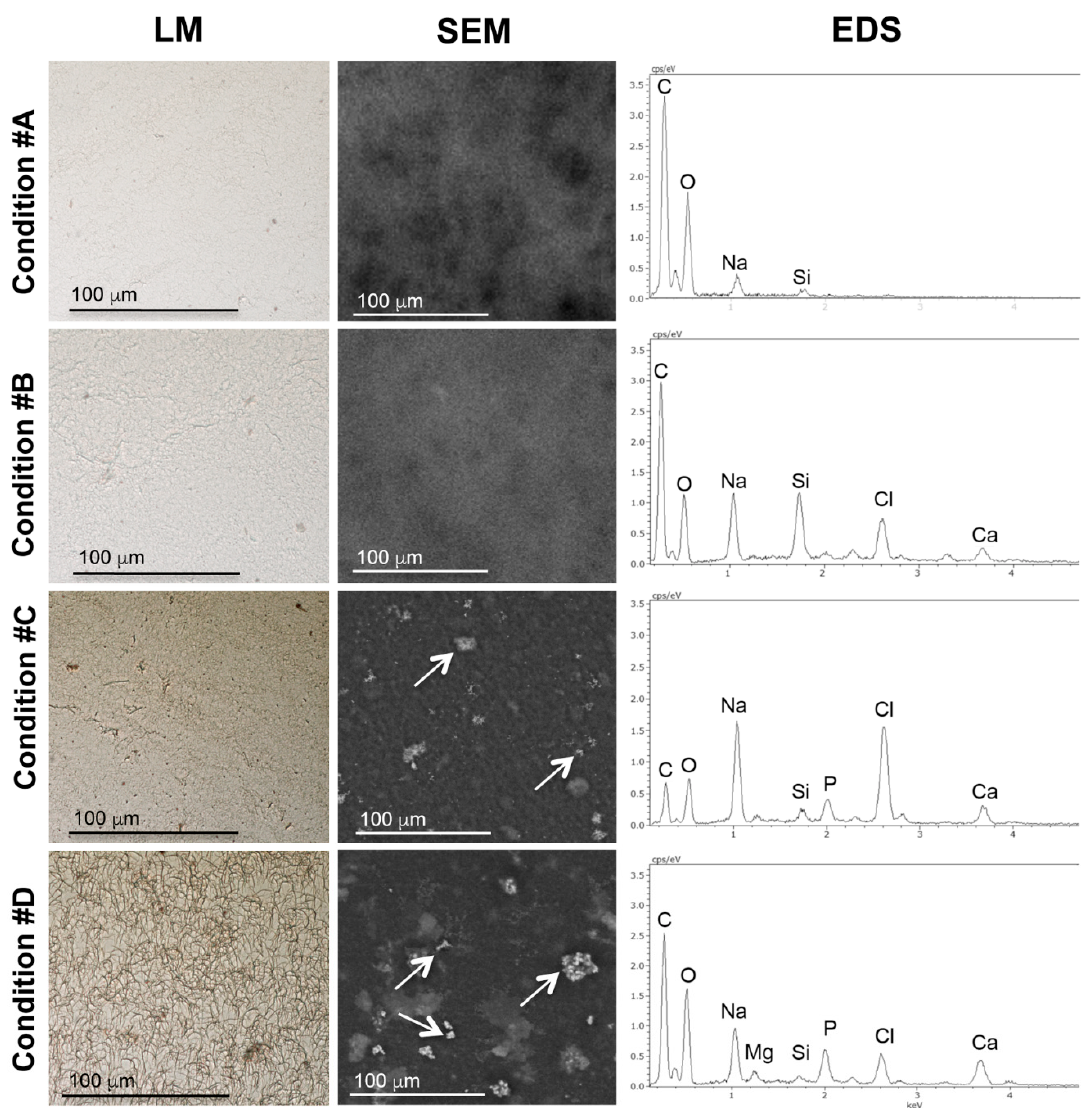
Figure 4. Structural characterization of mineral deposits after 24 h after gel polymerization. The presence of mineral deposits is visualized by Light Microscopy (LM) after von Kossa staining ( brown ). Shape and composition of mineral deposits is shown by SEM and Energy-Dispersive Spectroscopy (EDS) spectra. White arrows indicate apatitic deposits.